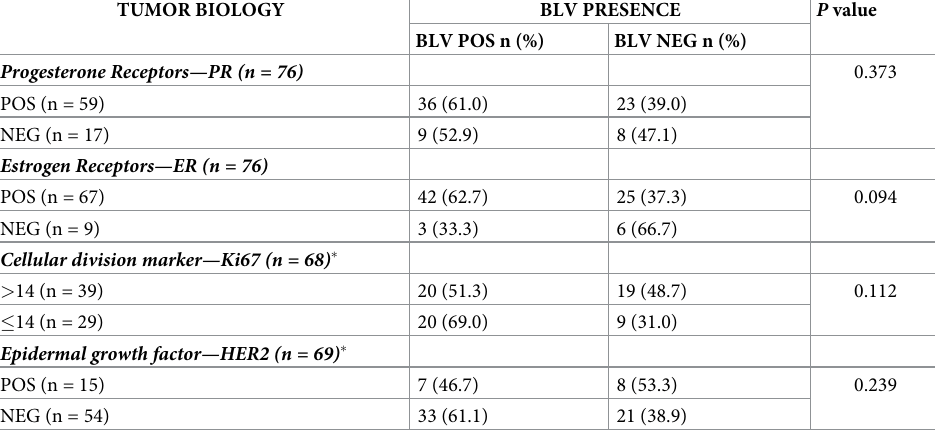
Table 4. Correlation between hormone receptors and prognostic markers for breast tumors with BLV